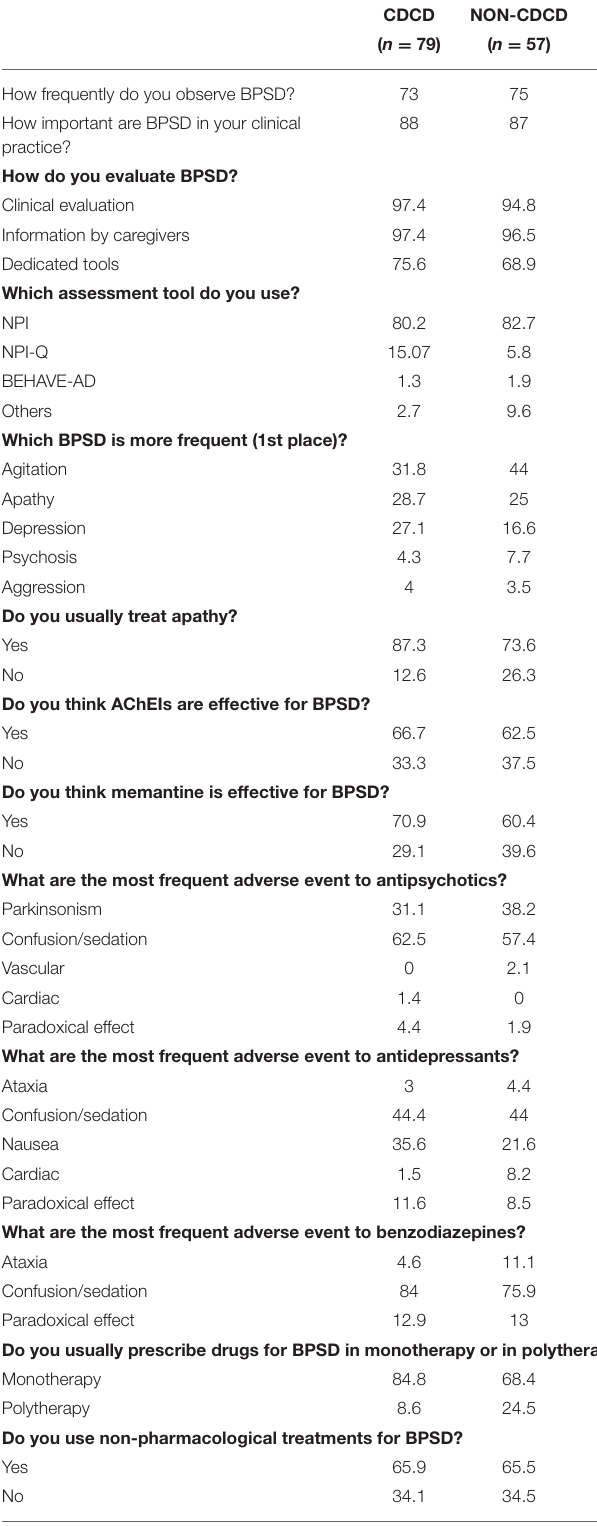
TABLE 1 | Answer differences in CDCD vs. non-CDCD setting; values ae expressed as